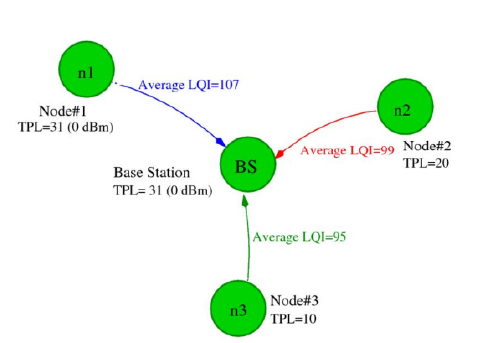
Figure 2. Sensor network with 3 nodes and a